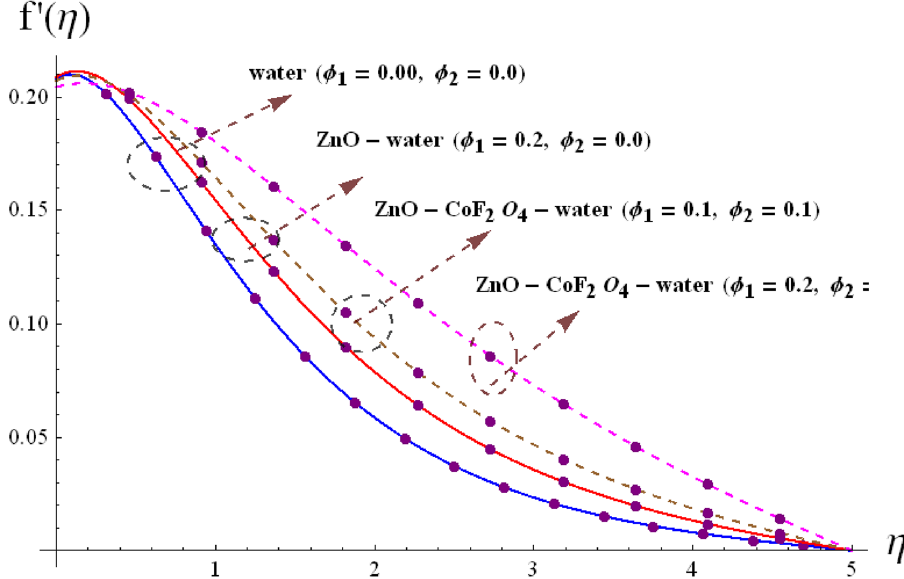
Figure 4. Variation of f ′ (η) via φ 1 /φ 2 .